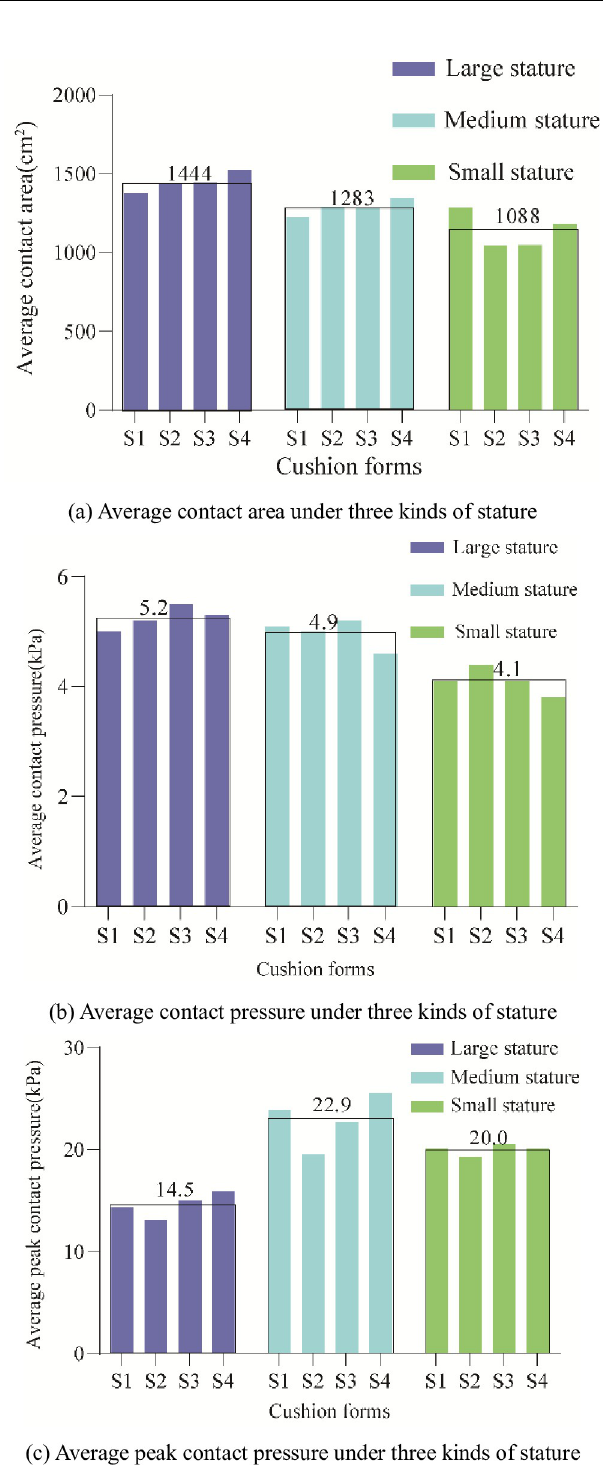
Fig 13. Statistical histogram of pressure distribution parameters of flat cushion under three kinds of stature. (a) Average contact area under three kinds of stature, (b) Average contact pressure under three kinds of stature, and (c) Average peak contact pressure under three kinds of